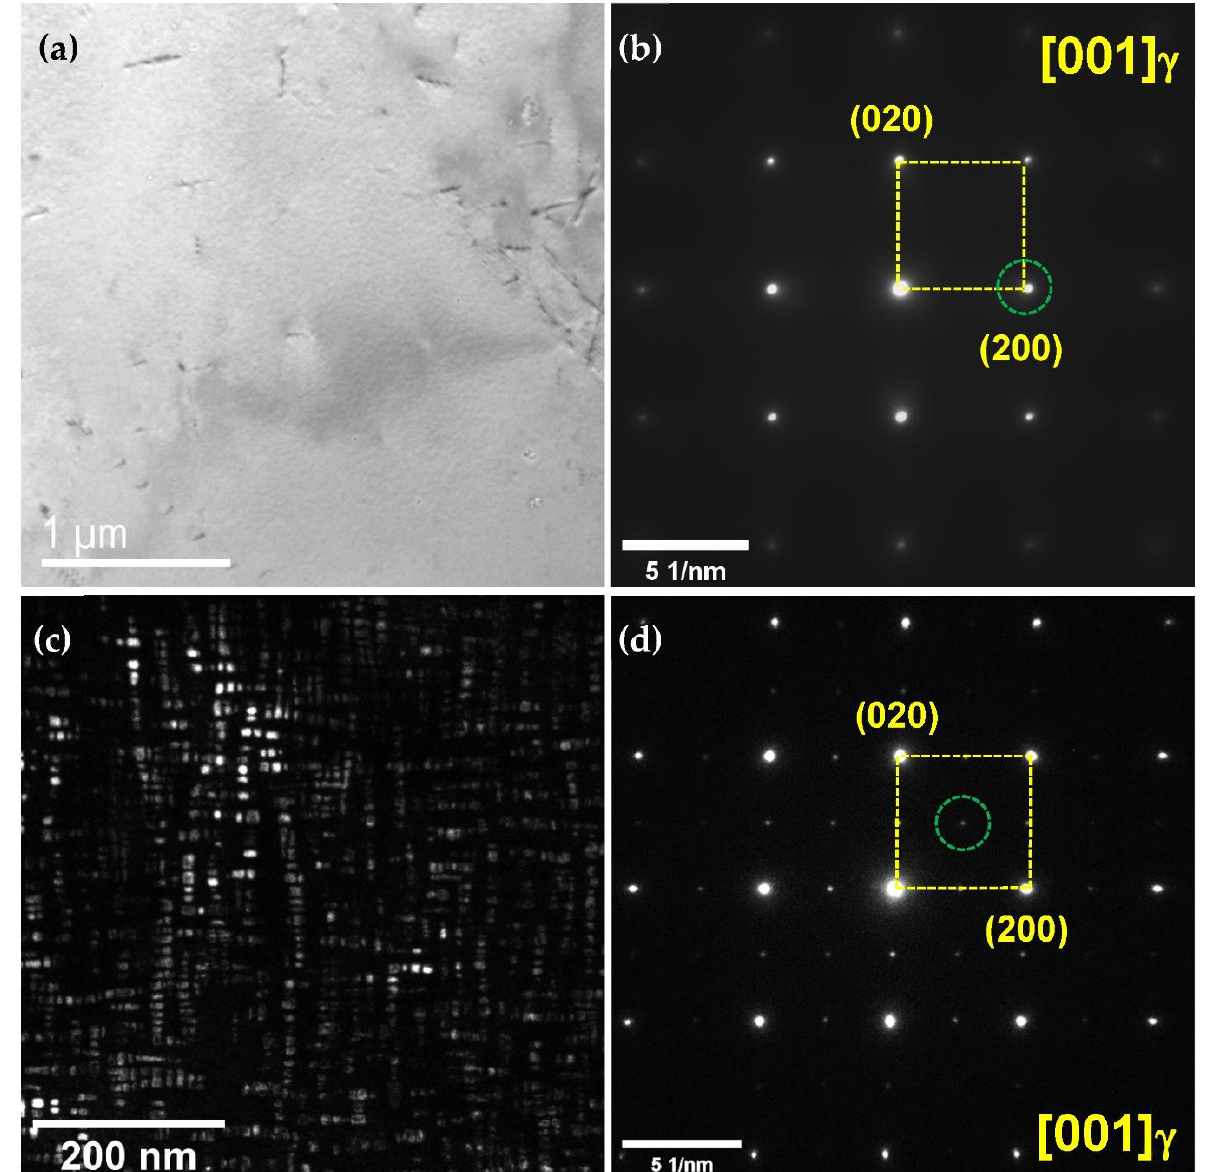
Figure 4. ( a ) Bright-field (BF) TEM image and ( b ) selected area diffraction pattern (SADP) of the as-annealed lightweight steel; ( c ) dark-field (DF) TEM image and ( d ) SADP of the aged lightweight steel. The DF-TEM image ( c ) was acquired using the diffraction spot of the κ -carbide, which is highlighted as a dotted green circle in ( d